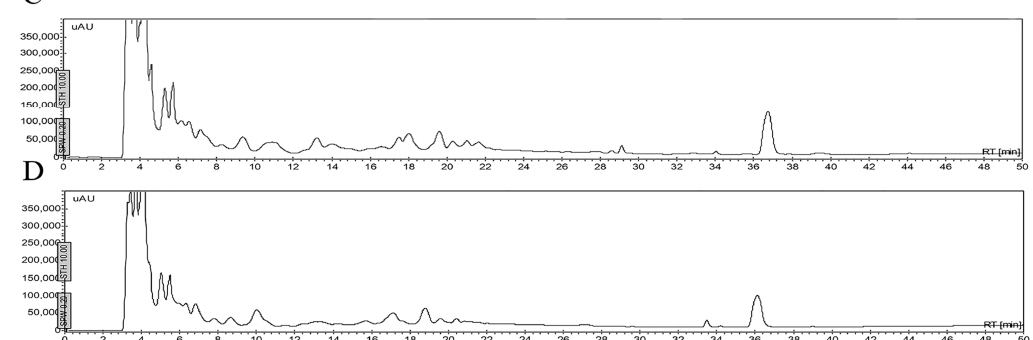
Figure 9. Stability of P18K in human blood plasma and bacterial supernatants. The peptide was either diluted in human blood or bacterial supernatants, incubated at 37 °C for 12 h and then extracted. ( A ) P18K was separated by HPLC (control); ( B ) P18K was diluted with blood, incubated for 12 h at 37 °C, extracted and separated by HPLC; ( C ) P18K was diluted with Staphylococcus aureus supernatant, incubated for 12 h at 37 °C, extracted and separated by HPLC; and ( D ) P18K was diluted with Pseudomonas aeruginosa supernatant, incubated for 12 h at 37 °C, extracted and separated by HPLC. The arrow shows the presence of P18K.